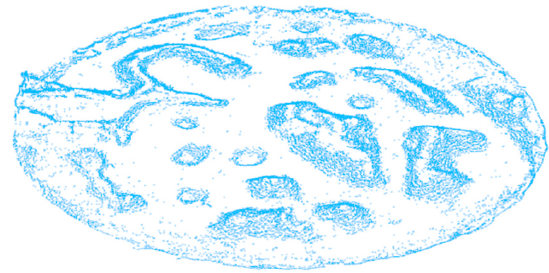
Figure 12. Results of obstacle extraction based on edge detection (82242 points).